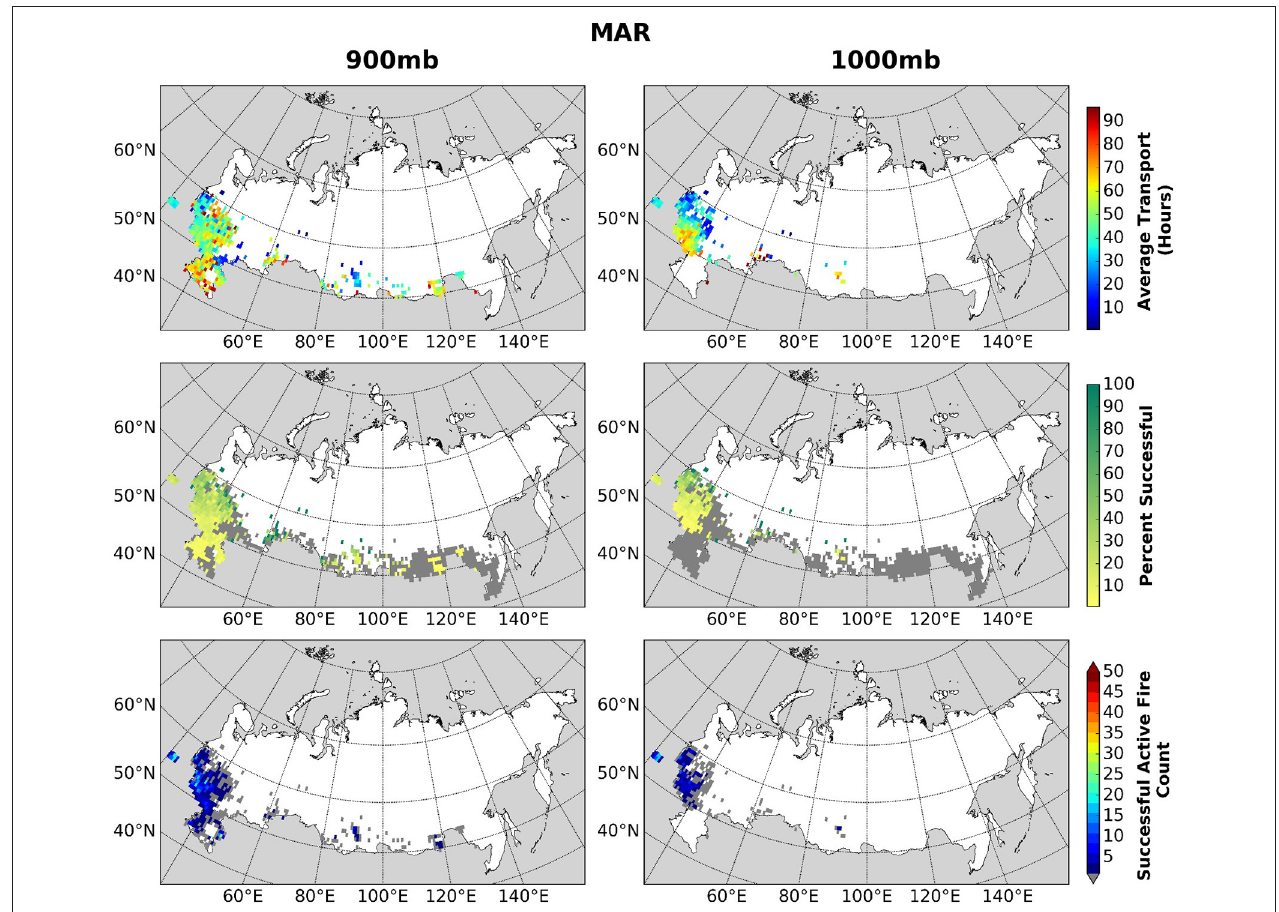
FIGURE 6 | 900 and 1,000mb March 2003–2015 average transport (hours), percent successful and active fires potentially contributing to BC deposition on snow in the Arctic. The dark gray color in the percent successful maps (middle) represents the starting fire locations which were unsuccessful at reaching the snow in the Arctic within